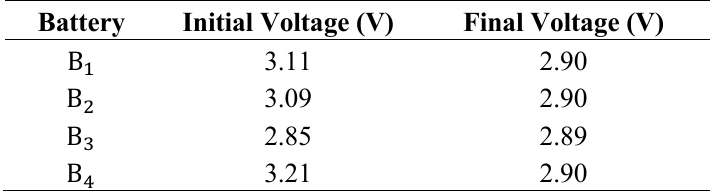
Figure 15. Experimental wave forms about DC-DC converter. Table 2. Battery voltages before and after charge equalization.